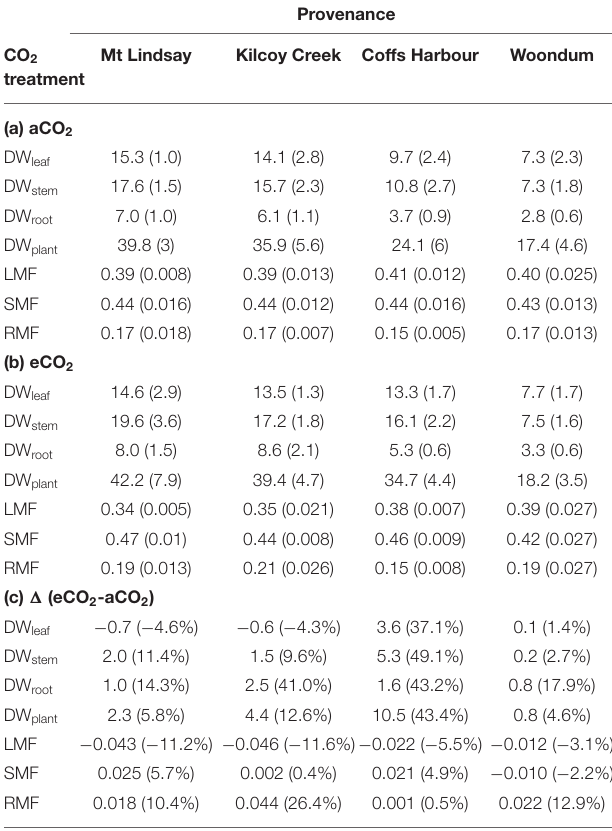
TABLE 3 | Dry mass (g) and biomass fractions of E. grandis at the end of Experiment 1. Provenance